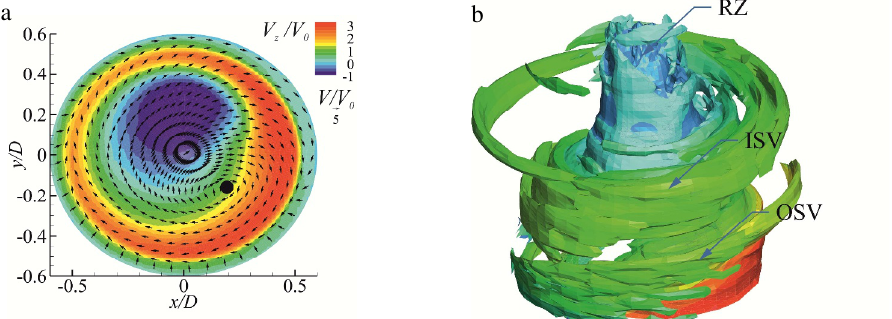
Fig. 4. Phase-averaged flow map ( S g =1.37, D =52 mm): velocity distribution in the cross-section near swirler nozzle z=3 mm (a), iso-surface of constant Q-criteria for visualization vortex structure in the axial swirler ( V z component of velocity pictured by